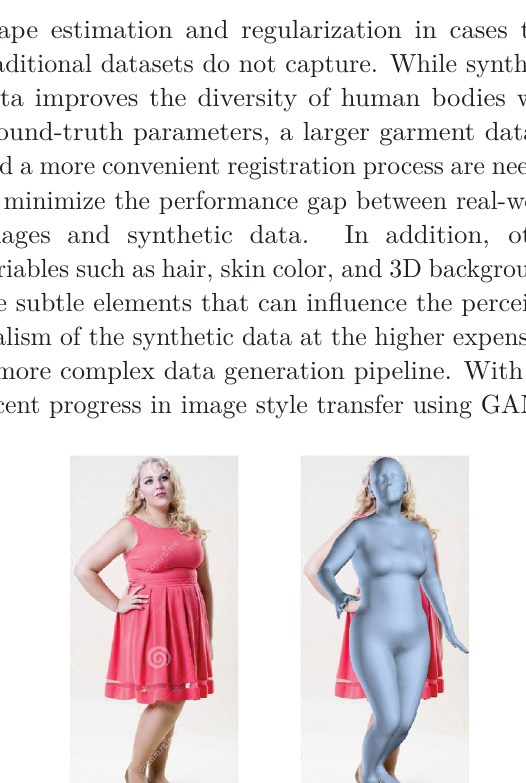
parameter prediction block computes the correction based on the image feature and the input guesses.